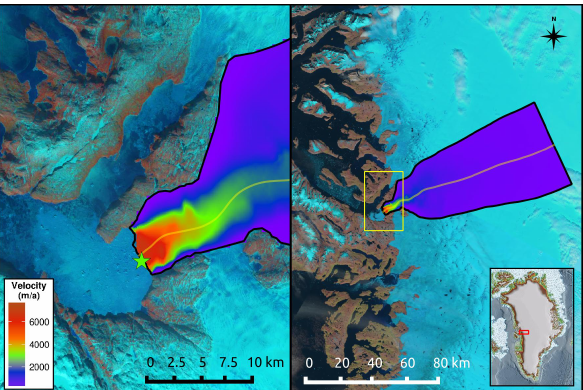
Figure 1. Store Glacier in Ikerasak Fjord, Greenland. Colour scale shows summer velocity (m a -1 ) from the MEaSUREs program (Joughin et al., 2011). Yellow line indicates the flowline used in this study, and the green star indicates the location of the main proglacial plume forming where subglacial water is discharged into the fjord.